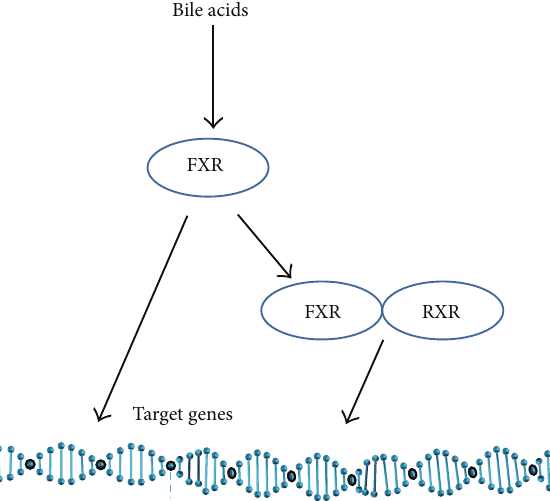
Figure 2: Mechanism of bile acid gene regulation. Bile acids can bind to the farnesoid X receptor (FXR) transcription factor which can regulate gene expression through binding to specific DNA motifs and can heterodimerize with retinoic X receptor- 𝛼 (RXR- 𝛼 ) to regulate the expression of target